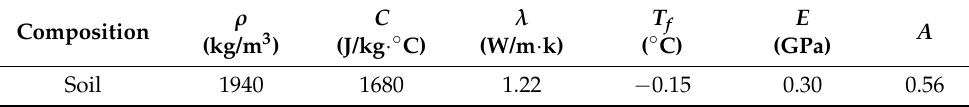
Table 2. Calculation parameters of the soil.